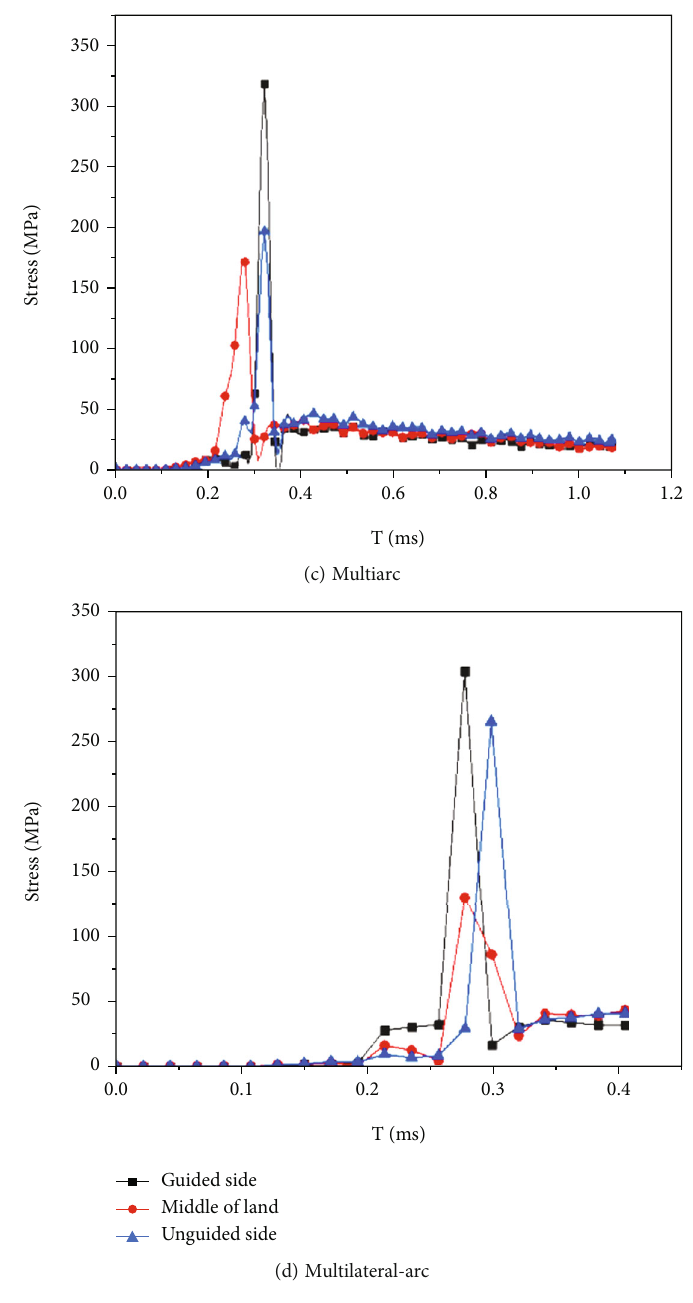
Figure 17: Stress distribution in barrels with di ff erent cross-sectional pro fi